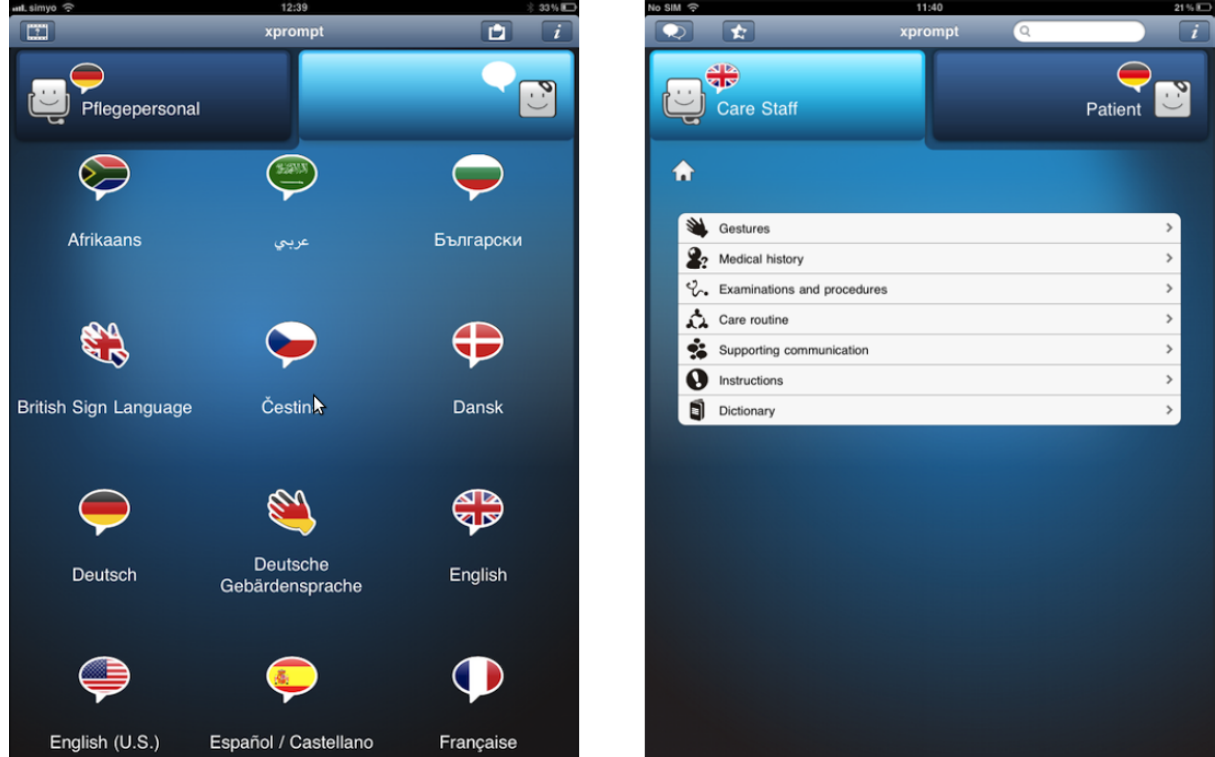
Figure 3. Choosing the languages to be used in xprompt (left). Typical menu entries for the care staff